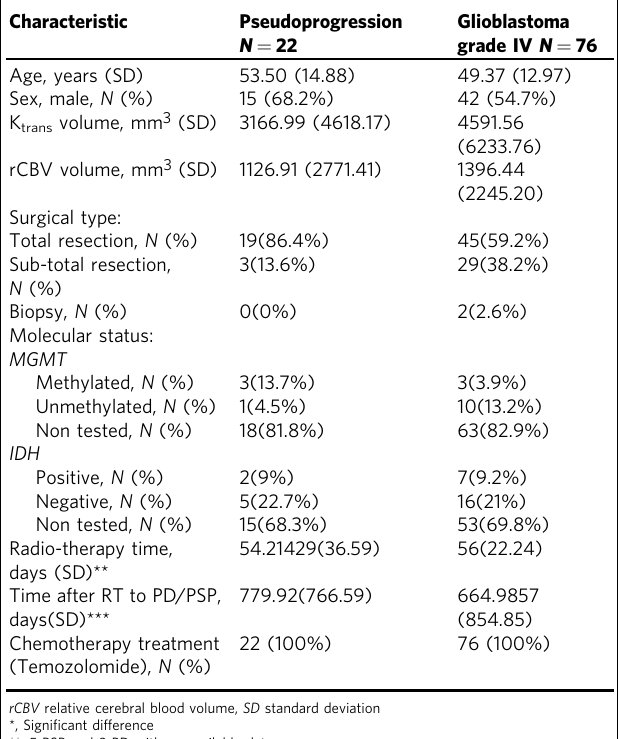
Table 1 Baseline selected demographic and clinical characteristics of patients with Pseudo